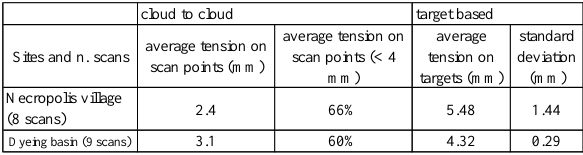
Table 3. Usual high accuracy evaluated for TLS results on CH.